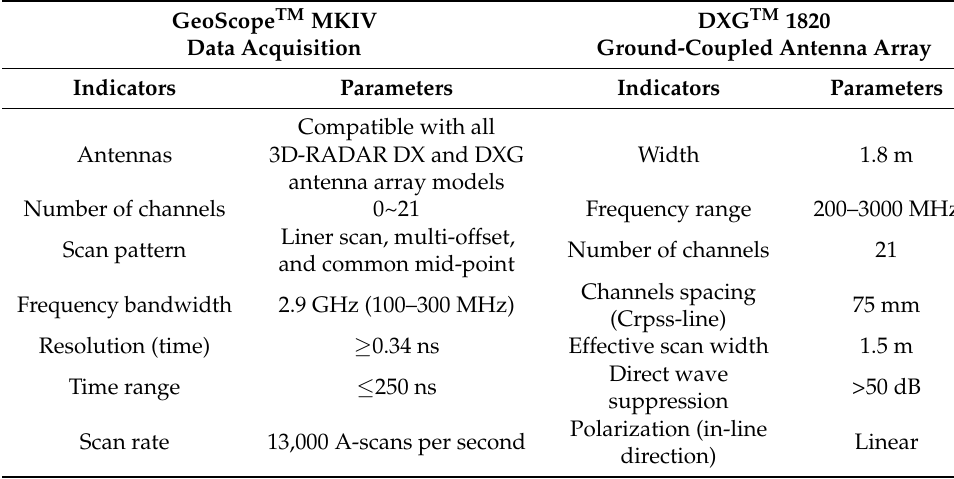
Table 2. The technical specifications of GeoScope TM MKIV and DXG TM 1820.